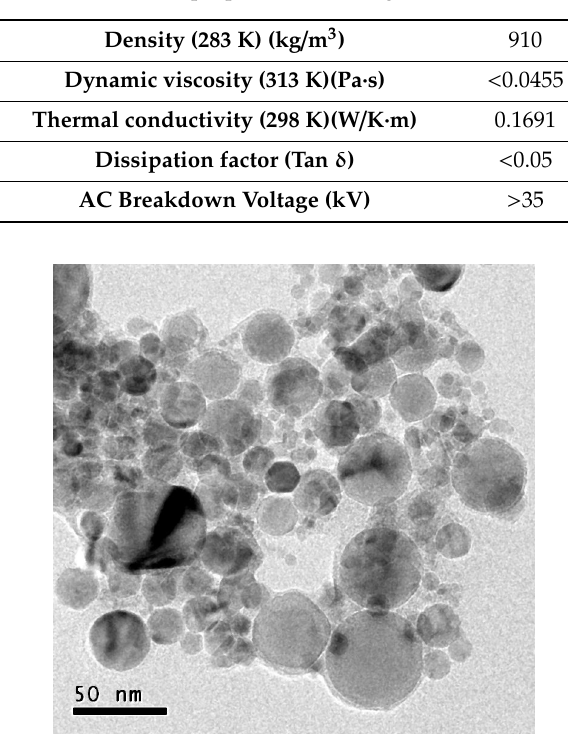
Figure 1. TEM image of a sample of TiO 2 nanoparticles.